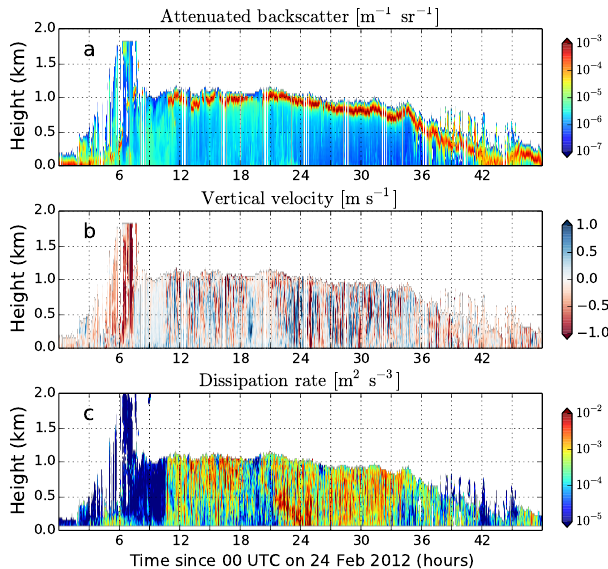
Figure 4. (a) Lidar backscatter, (b) Doppler velocity and (c) turbu- lence dissipation rate.